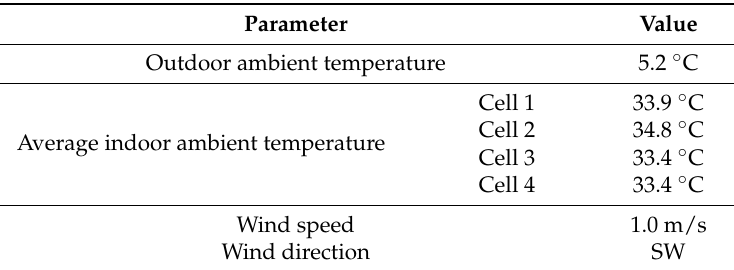
Table 5. Ambient conditions considered for the thermographic